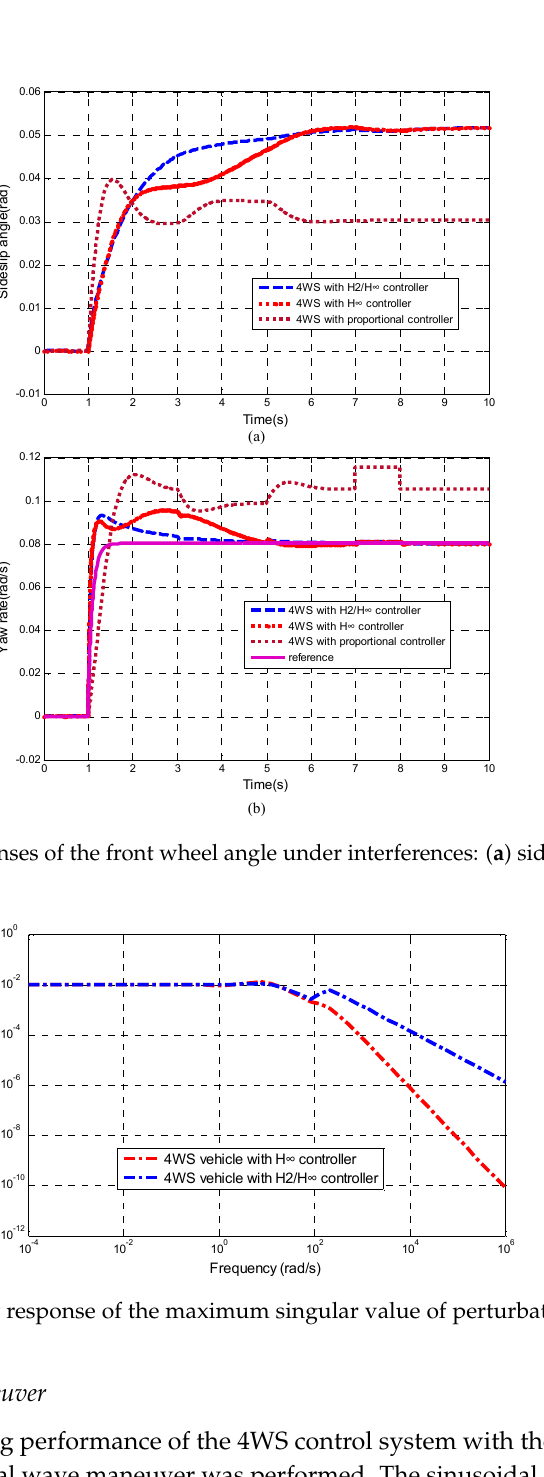
Figure 17. The disturbances signals: ( a ) side wind; ( b ) yaw rate sensor noise.